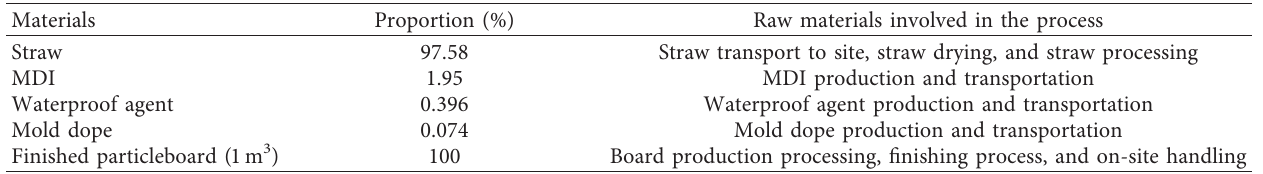
Table 2: Composition of straw particleboard production and the process